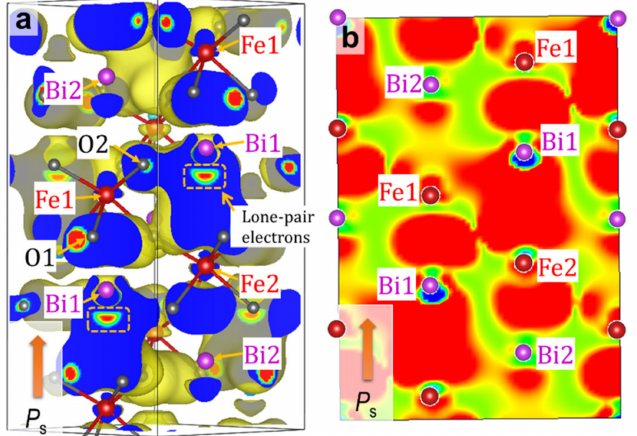
Figure 4. Wavefunction (partial charge density) of the ↑ band shown in the blue circle in ( i ) of the rhombohedral BiFeO 3 ( x = 0): ( a ) 3D plot and ( b ) 2D visualization on the lattice plane including Bi1 and Fe1. This wavefunction arising from an indirect Bi1_6 p –Fe1_3 d hybridization mediated through O_2 p is termed ‘Bloch function’. The roles of O1 and O2 in this band are almost identical, and therefore, we do not distinguish